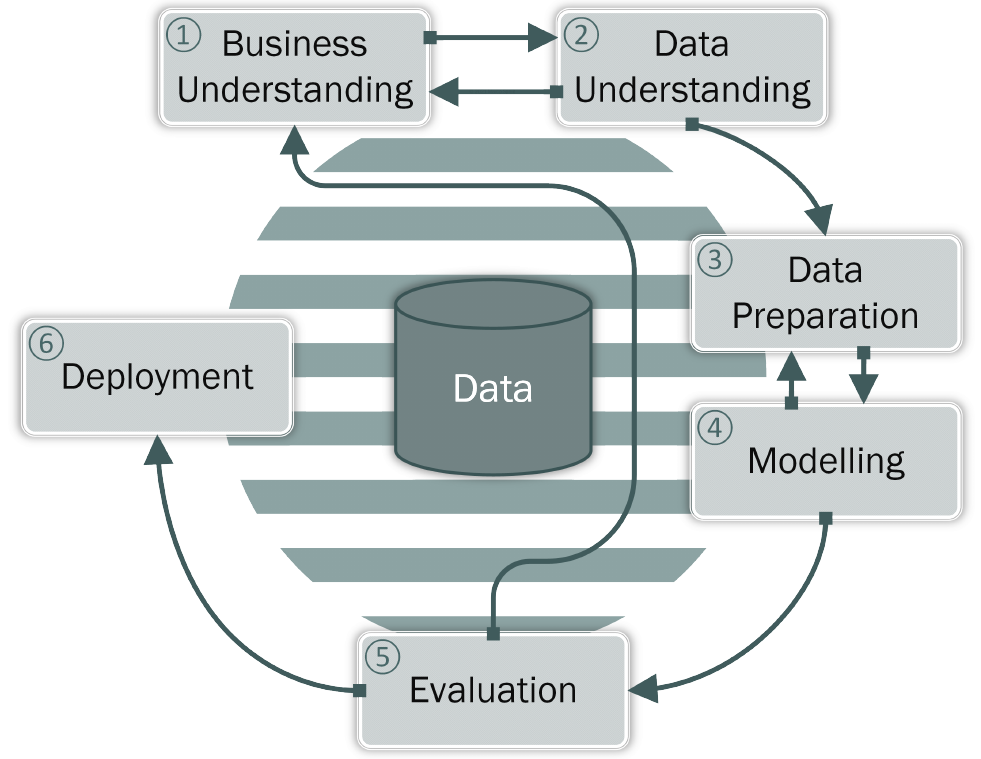
Figure 1. The CRISP-DM process starts with the Business Understanding phase, but does not specify how to determine business